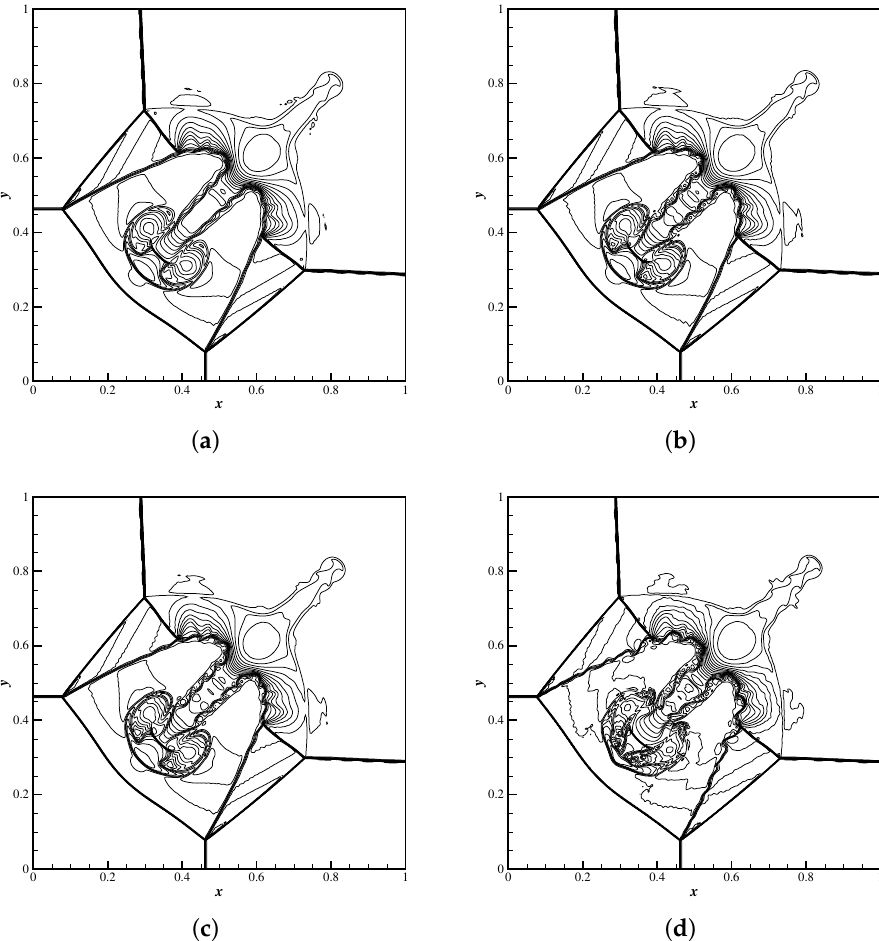
Figure 17. Density contours of the two-dimensional Riemann problem with 401 × 401 grid points. 24 equally distributed contours ranging from 0.2 to 1.7: ( a ) WCNS5-JS; ( b ) WCNS5-Z; ( c ) WCNS5-AS; ( d )